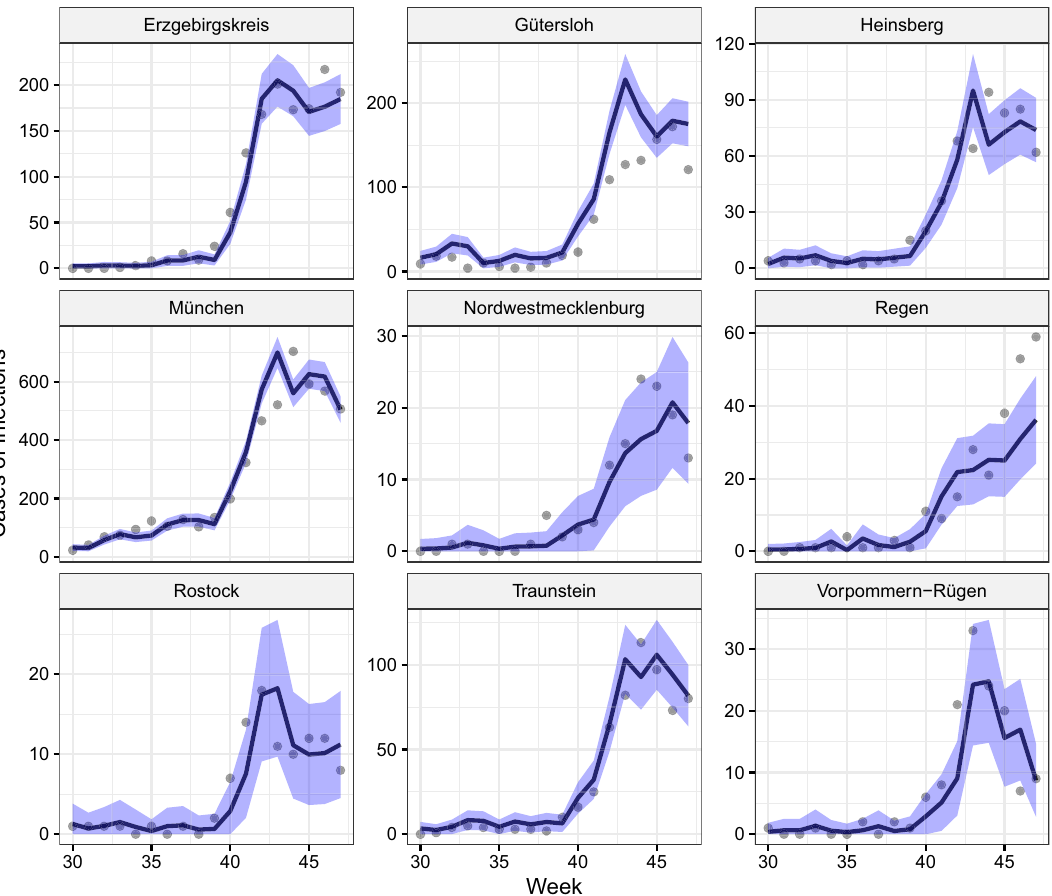
Figure 7. Exemplary prediction intervals for age group 35–59 and gender male (results of other groups can be found in the Appendix) and selected districts (facets) in Germany. For the different forecast weeks (x-axis) the true number of infections are visualized by points and contrasted with the model’s prediction (black line) and the prediction interval (shaded purple